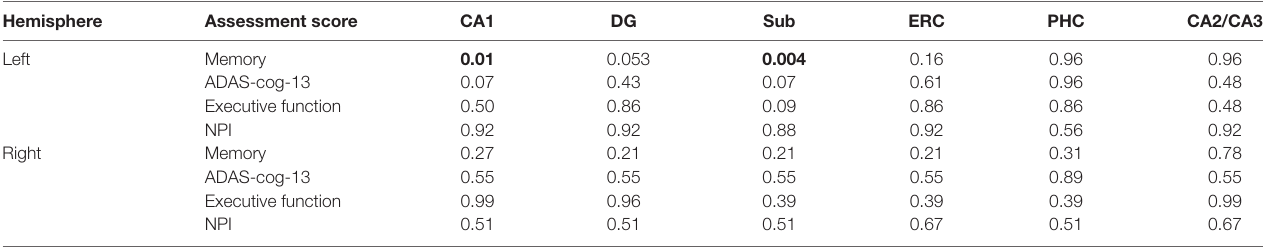
Bold values mean the p’s < 0.05 and statistically significant. TABLE 5 | Associations between assessment scores and tau SUVR of the hippocampal subfields for A+ group ( p < 0.05, FDR correction). Hemisphere Left